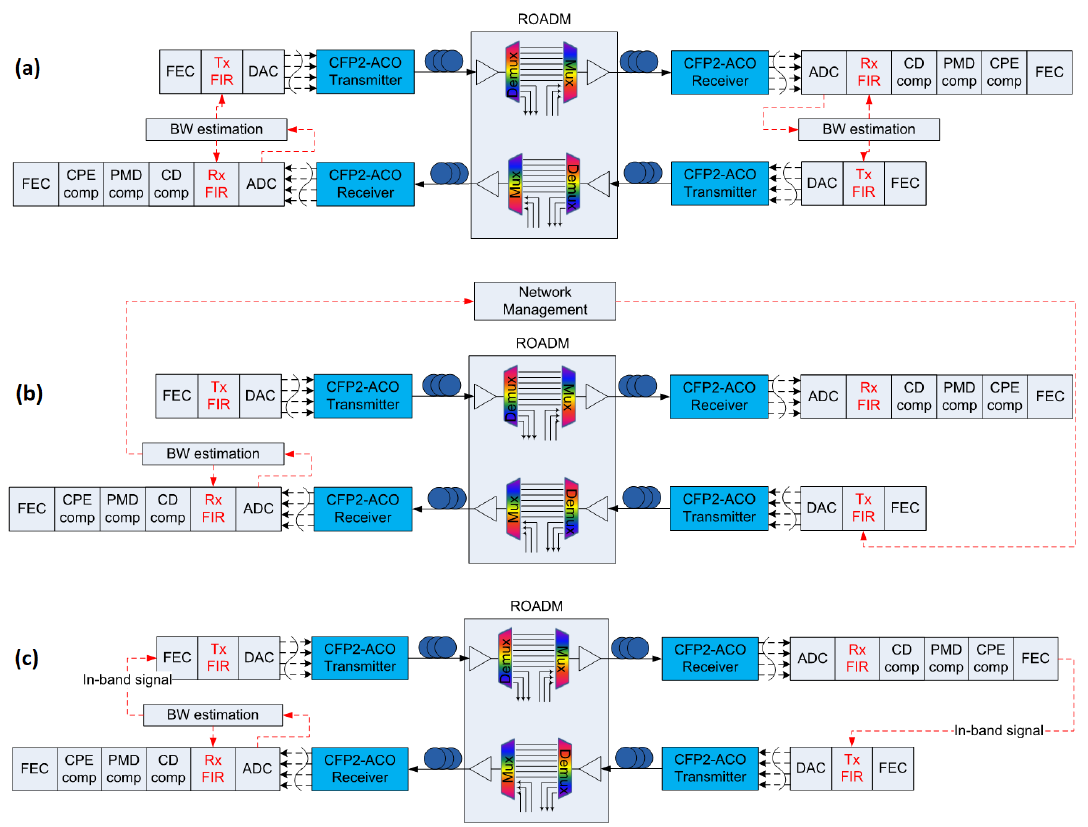
Figure 9. Application scenarios for different network topologies. ( a ) The estimated signal bandwidth is directly fed back from the coherent receiver to the coherent transmitter in a bi-directional link. ( b ) The estimated signal bandwidth is fed back through the network management layer. ( c ) The estimated signal bandwidth is fed back through the in-band